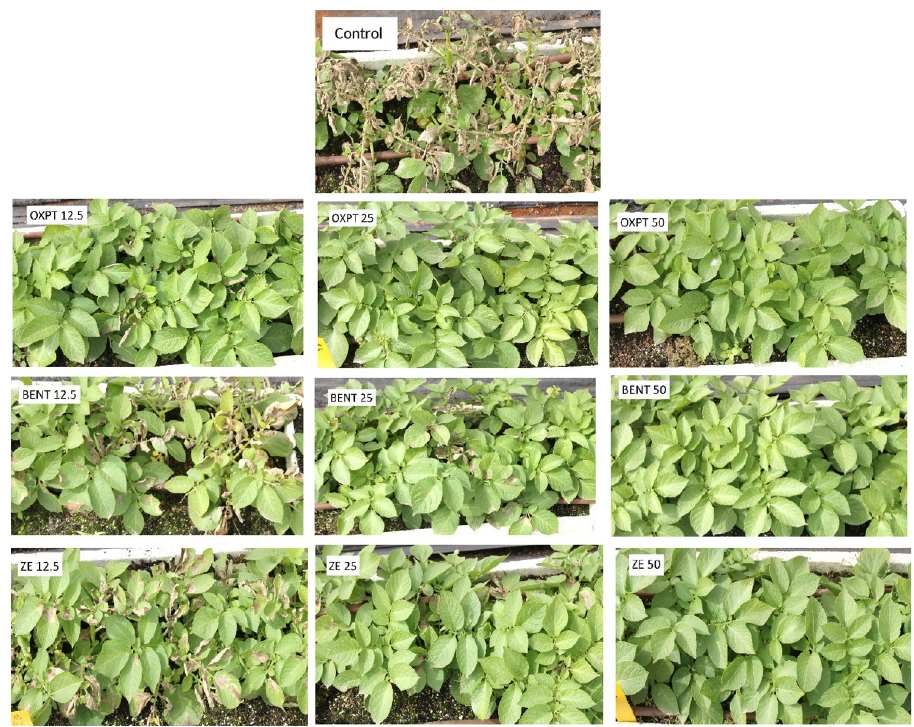
Fig 7. Systemic protection of potato Sifra against late blight caused by an MFX-resistant isolate of Phytophthora infestans under field conditions. Potato plants grown in 64 L containers were treated by a soil drench of 12.5, 25, or 50 mg ai fungicide suspension per container (n = 3). At 25 days after treatment the plants were inoculated with a sporangial suspension of isolate 164 of this pathogen. Photo was taken at 10